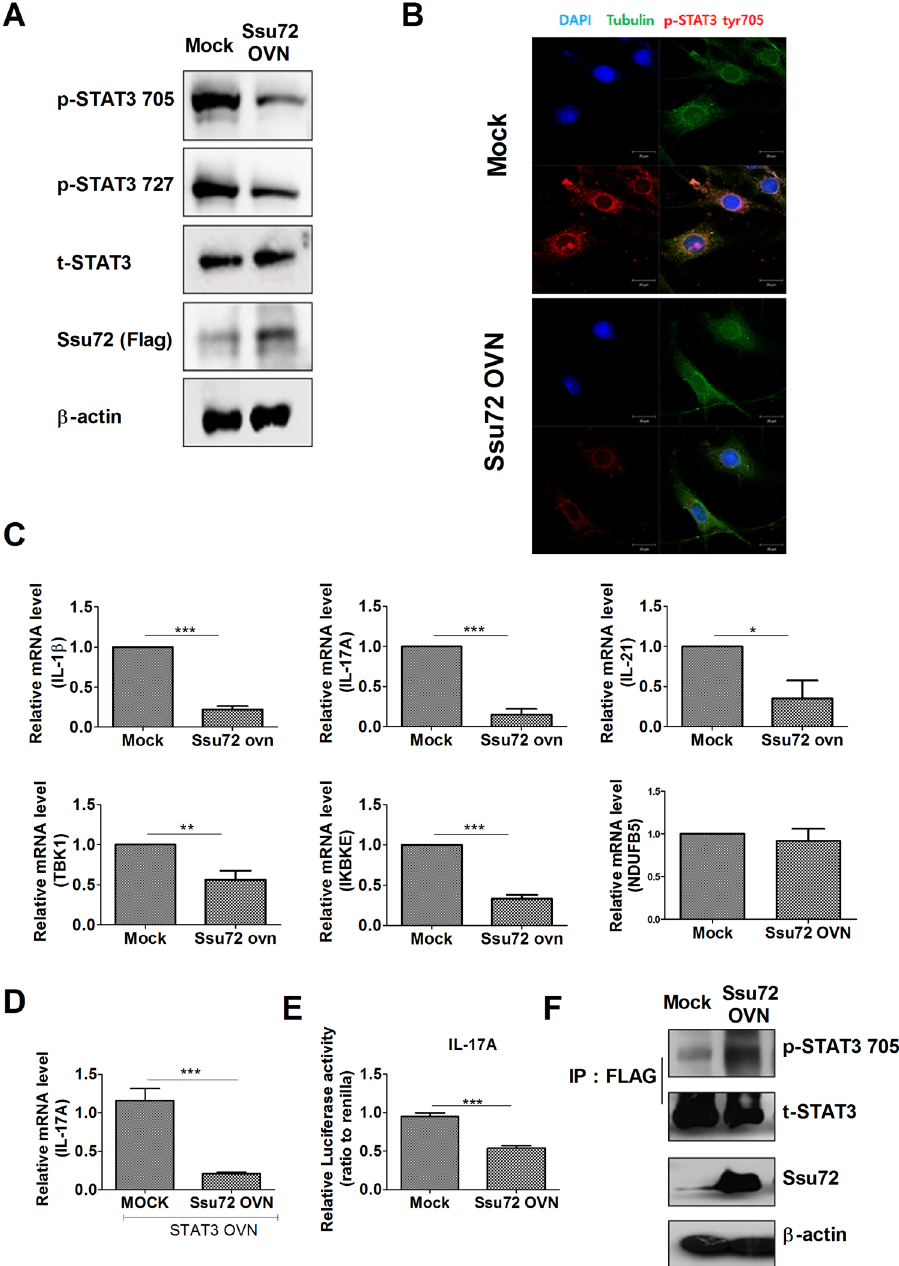
Figure 1. Ssu72 regulates STAT3 activation. ( A ) NIH-3T3 cells were transfected with either the mock or Ssu72 overexpression vector and stimulated with IL-6 (20 ng/ml) for 1 h. Cells were used to detect the p-STAT3 Tyr705 and p-STAT3 Ser727 levels. ( B ) NIH-3T3 cells were stained with DAPI (blue) and antibodies against tubulin (green) and p-STAT3 Tyr705 (red). Confocal scanning microscopy was performed to detect the p-STAT3 Tyr705 and p-STAT3 Ser727 levels in the transfected cells. ( C ) NIH-3T3 cells were transfected with the expression vector and stimulated with IL-6 (20 ng/ml) for 1 h. ( D ) Cells were transfected with STAT3 overexpression vectors and either the mock or Ssu72 overexpression vector. The expression levels of the Il17a mRNA were measured using real-time PCR. ( E ) NIH-3T3 cells were transfected with the Il17a promoter construct and either mock or Ssu72 expression vectors. Luciferase activity was then detected. ( F ) Lysates from the transfected NIH-3T3 cells were immunoprecipitated with the anti-FLAG antibody and immunoblotted with anti-p-STAT3 Tyr705, anti-p-STAT3, and anti-Ssu72 antibodies. The data represent the mean ± SD from three independent experiments. Statistical analyses were conducted using the nonparametric Mann-Whitney U -test ( * P < 0.05, *** P <